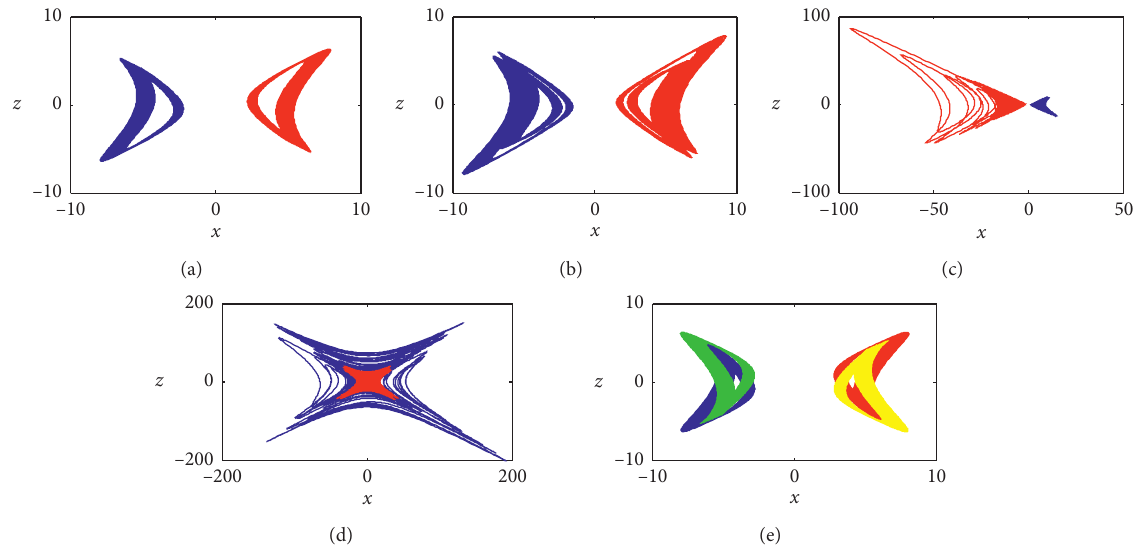
Figure 5: Various coexisting attractors with different values of parameter d in the x − z plane: (a) d � − 3, (b) d � − 0 . 5, (c) d � 0, (d) d � 15, and (e) d � − 7.